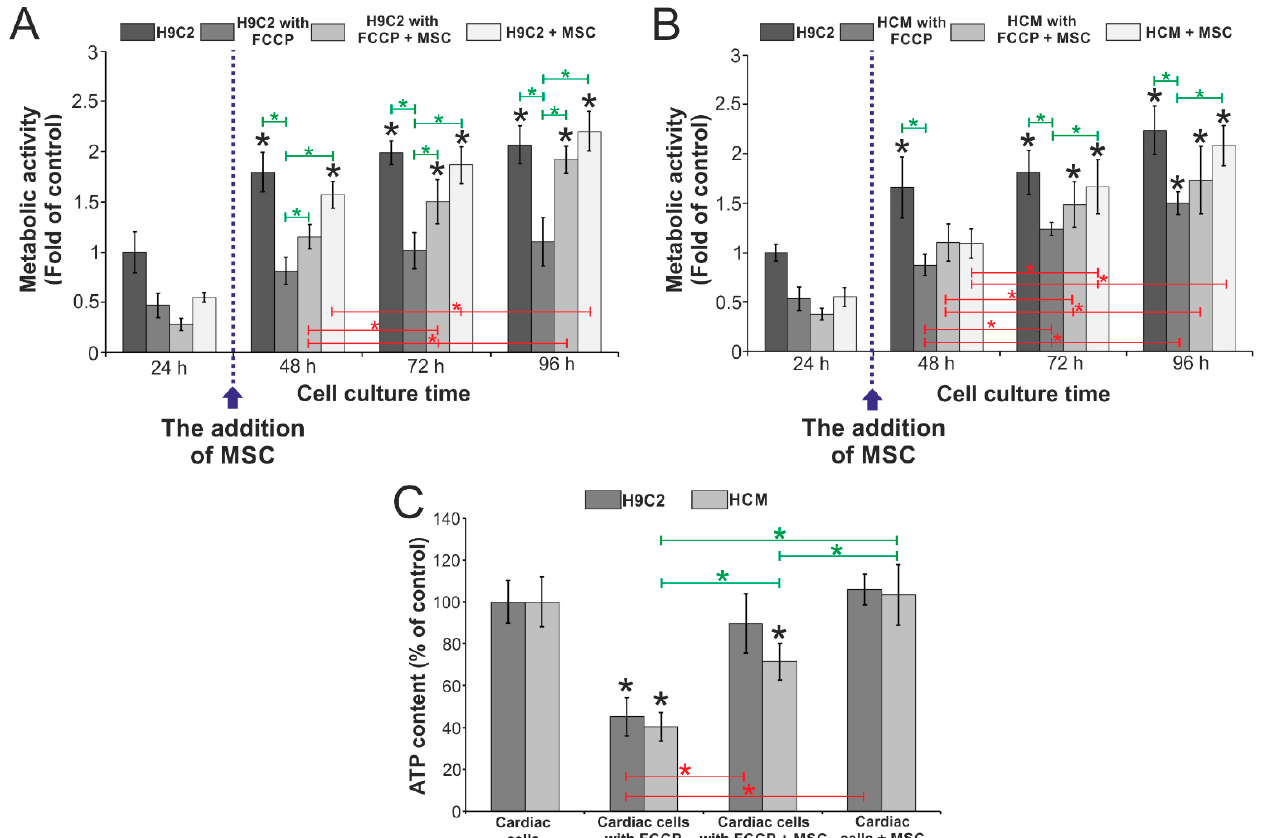
Figure 4. The results of metabolic activity measurements of ( A ) rat cardiomyoblasts and ( B ) human cardiomyocytes. N ≥ 3, asterisks ( p < 0.05) signify statistical significance relative to control (black), between culture times for the same cell culture (red) and between different types of culture (green). ( C ) The results of measuring the adenosine triphosphate (ATP) molecule content in the four tested types of cell culture in the microsystem for two cardiac cells lines. N ≥ 3, asterisks ( p < 0.05) signify statistical significance relative to control (black), between cell cultures with H9C2 (red) and between cell cultures with HCM (green).